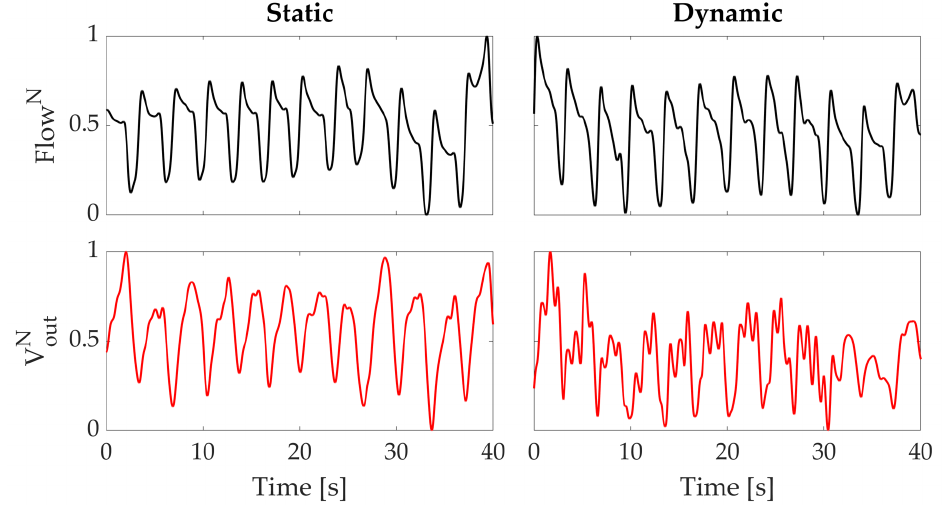
Figure 6. Normalized output data from the wearable system ( V N used. The left plots show the signals obtained in the static task; the right ones show the signals obtained in the dynamic task.